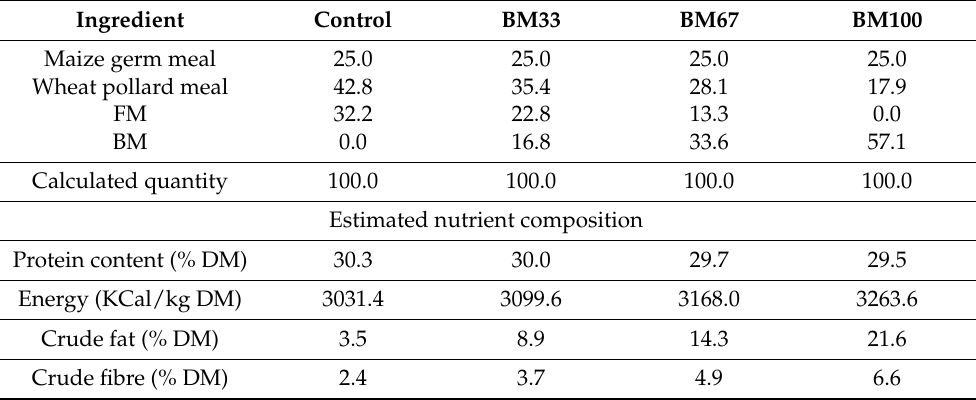
Table 1. Composition of ingredients in the experimental